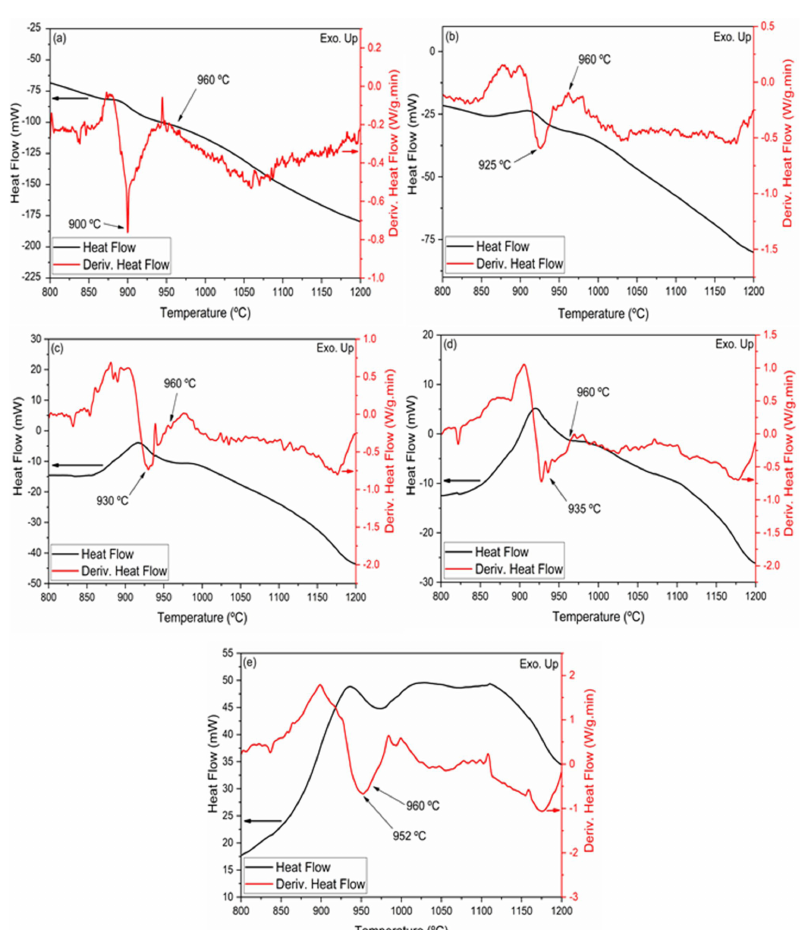
Figure 9. Differential scanning calorimetry of Ca Glass. Heating rate of (a) 10 ºC/min, (b) 15 ºC/min, (c) 20 ºC/min, (d) 25 ºC/min and (e) 30